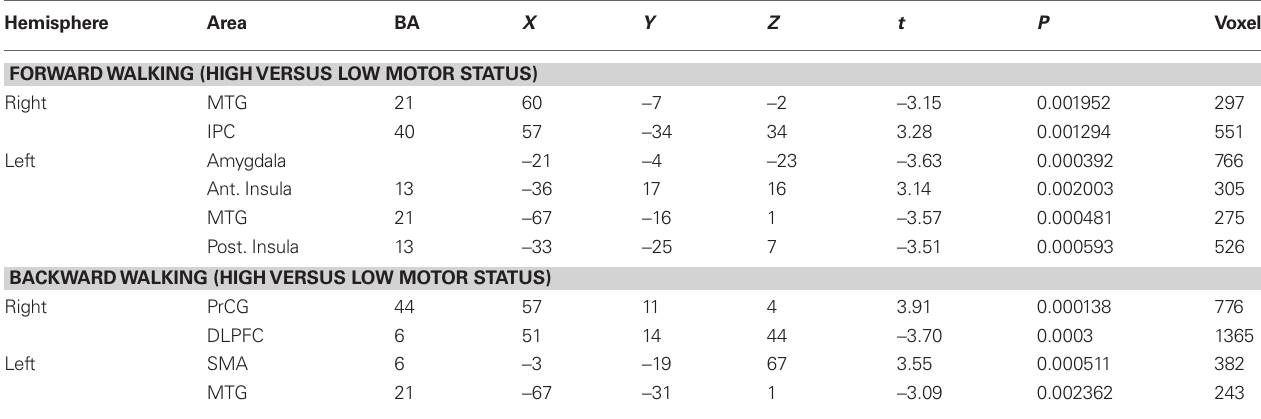
Table 5 | Talairach coordinates, t - and P -values, and voxel numbers of significant regions of interest for imagination of backward and forward walking in high- versus low-fit participants.